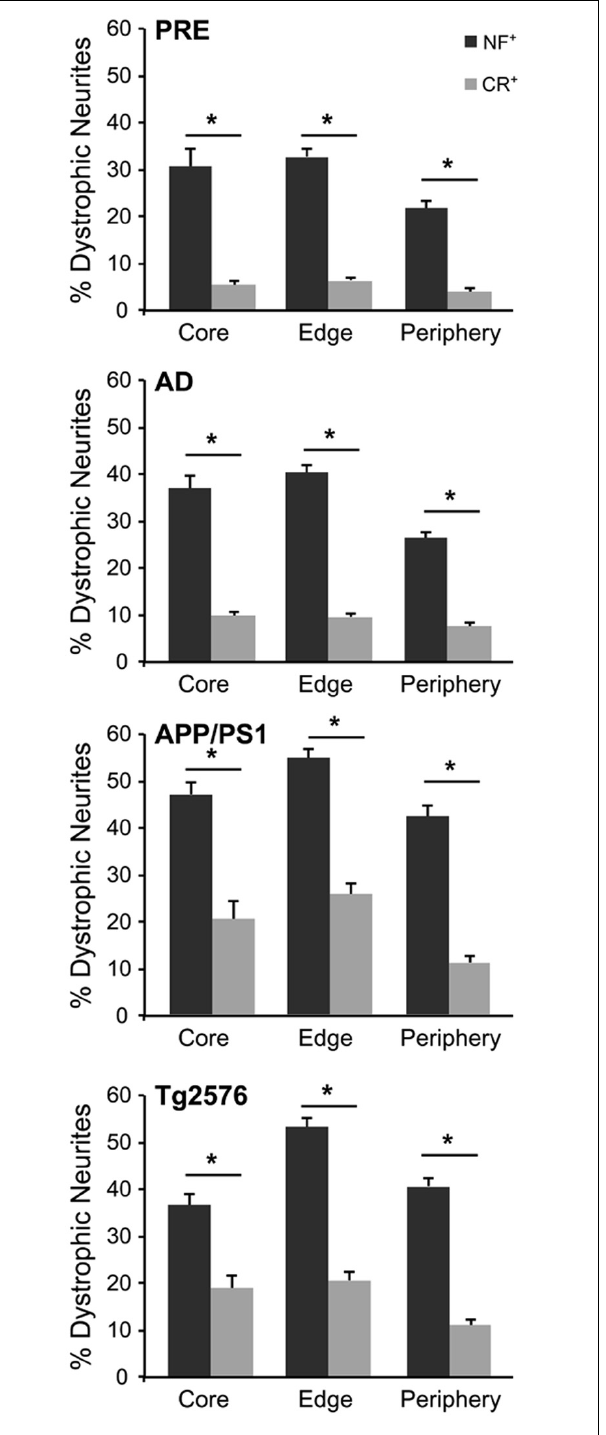
FIGURE 1 | Double-immunofluorescence for NFs (SMI312 and SMI32) and thioflavin-S (A–C) or calretinin and thioflavin-S (D) with a superimposed template showing the plaque-core, the plaque-edge, and the periphery. Small arrows (A,C) denote characteristic swellings in dystrophic neurites, large arrows (B) highlight increased neurite curvature and tortuosity, while arrowheads (D) show normal-appearing neurites. Scale bar = 20 μ m.